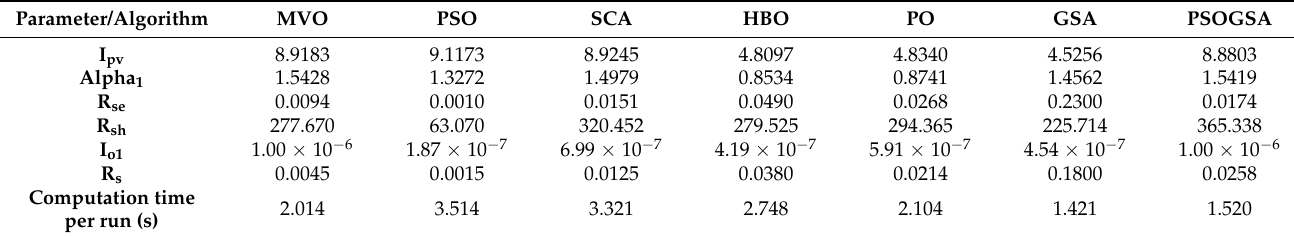
Figure 10. The convergence curve of the monocrystalline MTDM. Table 9. The MTDM calculation error, mean and standard deviation for the monocrystalline PV Table 12. Parameter Estimation of the MSDM for the polycrystalline PV Cell .